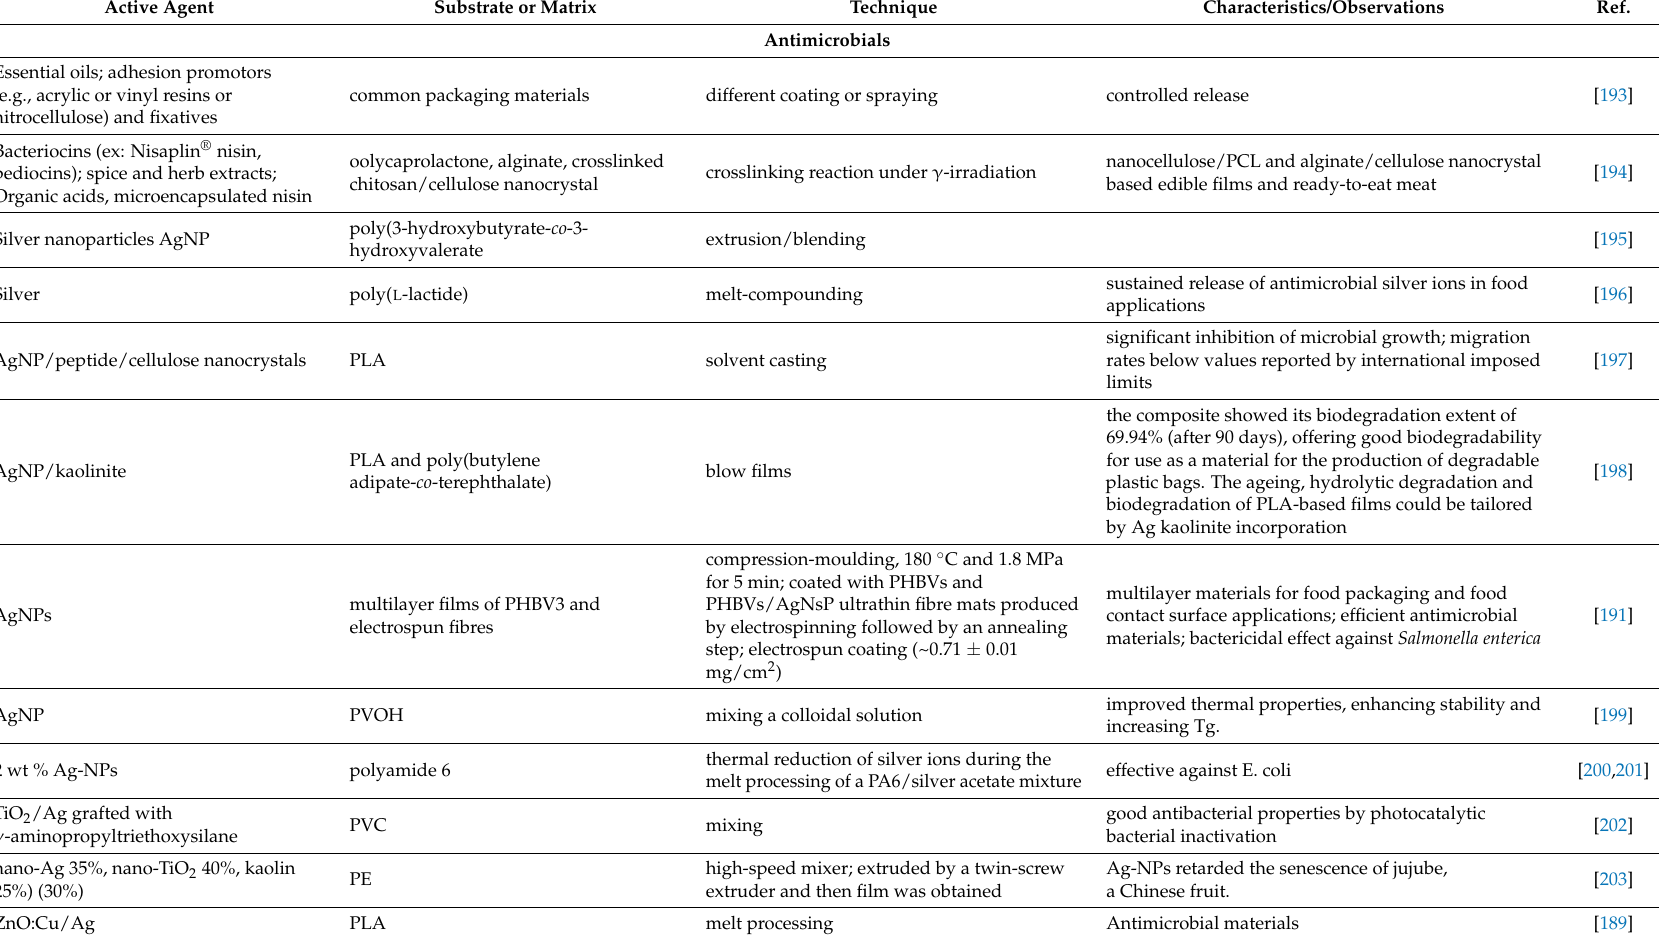
Table 3. Formulations including antimicrobials as bioactive compounds intended to use in food